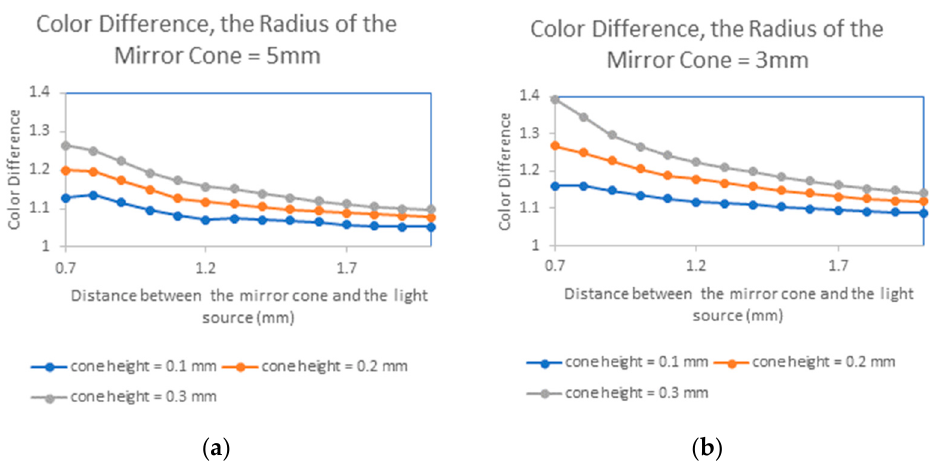
Figure 3. The color difference. We define the color difference as (the average energy received by all the pixels in the left-half detector plane) divided by (the average energy received by all the pixels in the right-half detector plane). ( a ) Color difference when the radius of the mirror cone is 5 mm, and ( b ) when the radius of the mirror cone is 3 mm.